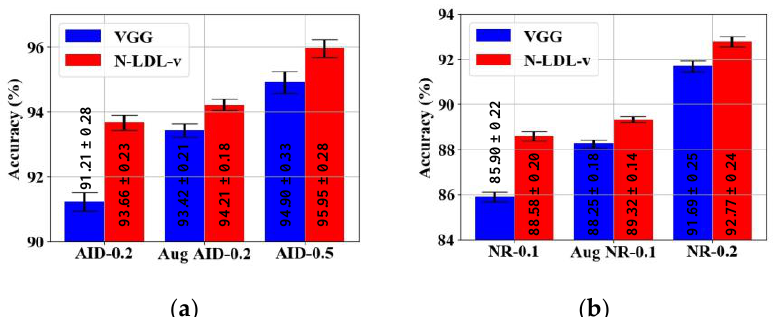
Figure 13. Classification results using different sizes of training sets on datasets of ( a ) AID and ( b ) NR. (1) Our method can mitigate over-fitting